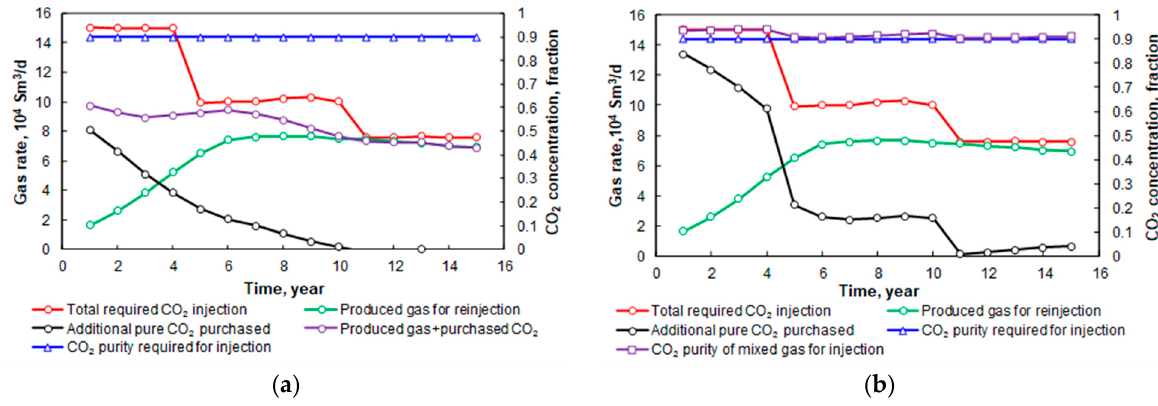
Figure 10. ( a ) Based on the required CO 2 purity. ( b ) Based on the required injection amount. Two types of produced gas mixed with the purchased pure CO 2 in the DRM process of case D.